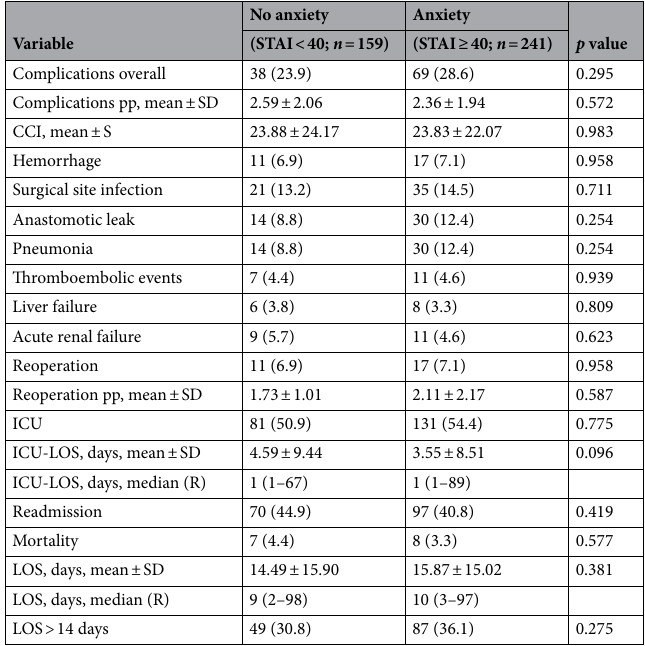
Table 3. Outcomes ( N = 400). pp, per patient; surgical site infection is defined as being contained within the skin or subcutaneous tissue (superficial), or involving the muscle and /or fascia (deep); CCI, the comprehensive complication index; ICU, intensive care unit requirement; LOS, length of hospital stay defined as the time from the date of the initial admission to the date of discharge, transfer to external services, or death, which ever came first. Numbers in bracket indicate values presented in n